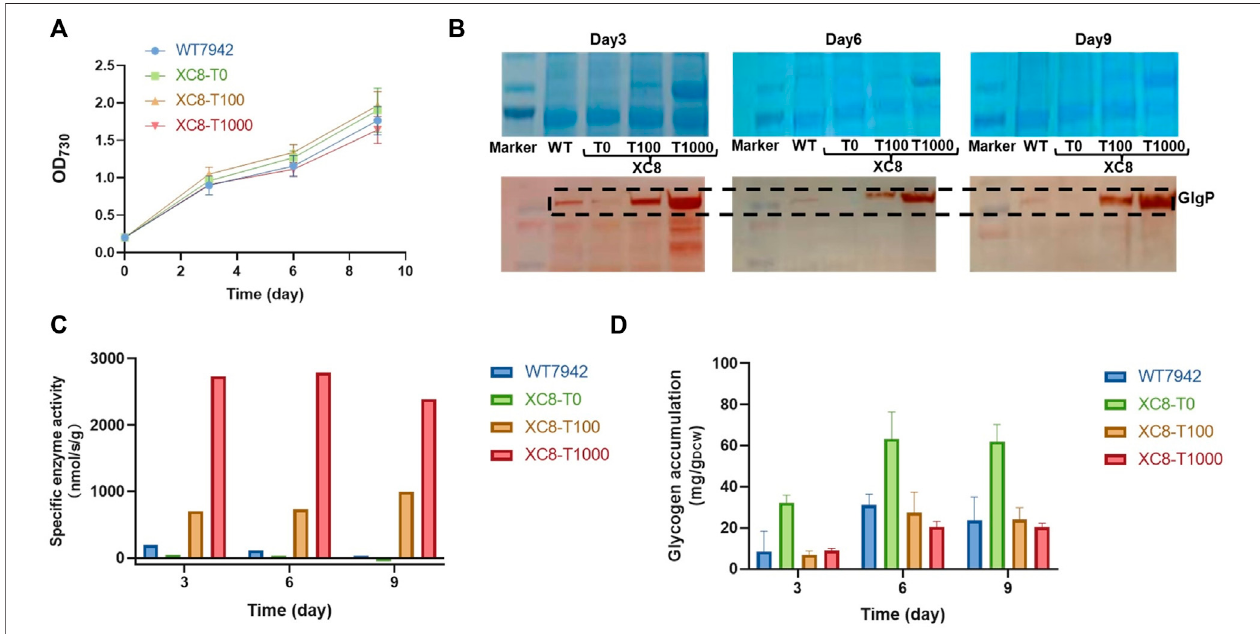
FIGURE 2 | Theophylline-regulated glgP expression and glycogen storage in PCC 7942. (A) Cell growths, (B) GlgP abundances, (C) glycogen phosphorylase activities, and (D) glycogen contents of XC8 strain induced with different concentrations of theophylline during the 10 days of cultivation. To con fi rm the effects of theophylline induction on glgP expression regulation, different concentrations of theophylline (0 μ M, T0; 100 μ M, T100; 1,000 μ M, T1000) were supplemented into culture broth of XC8 strain in fl asks. The cells would be sampled on Day 3, Day 6, and Day 9 for GlgP Western blot assays, glycogen phosphorylase activity calculations, and glycogen content